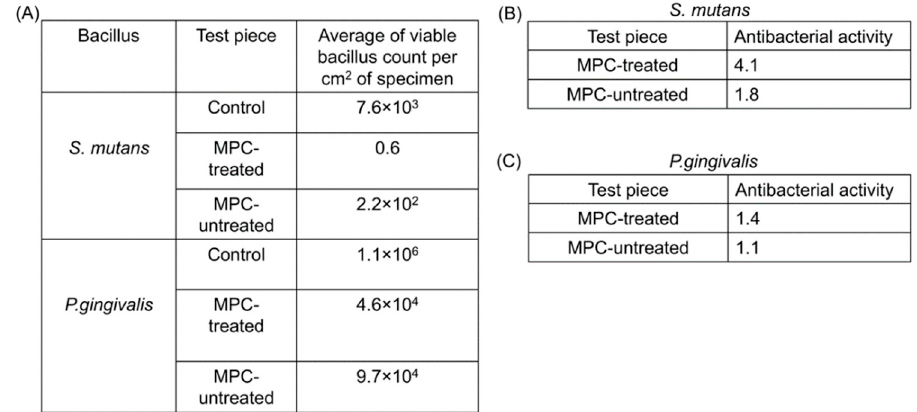
Figure 4. Antimicrobial effects of MPC-coating treatment. ( A ) The results of antimicrobial tests for Streptococcus mutans and Porphyromonas gingivalis ; ( B ) The results of antibacterial activity for Streptococcus mutans ; ( C ) The results of antibacterial activity for Porphyromonas gingivalis